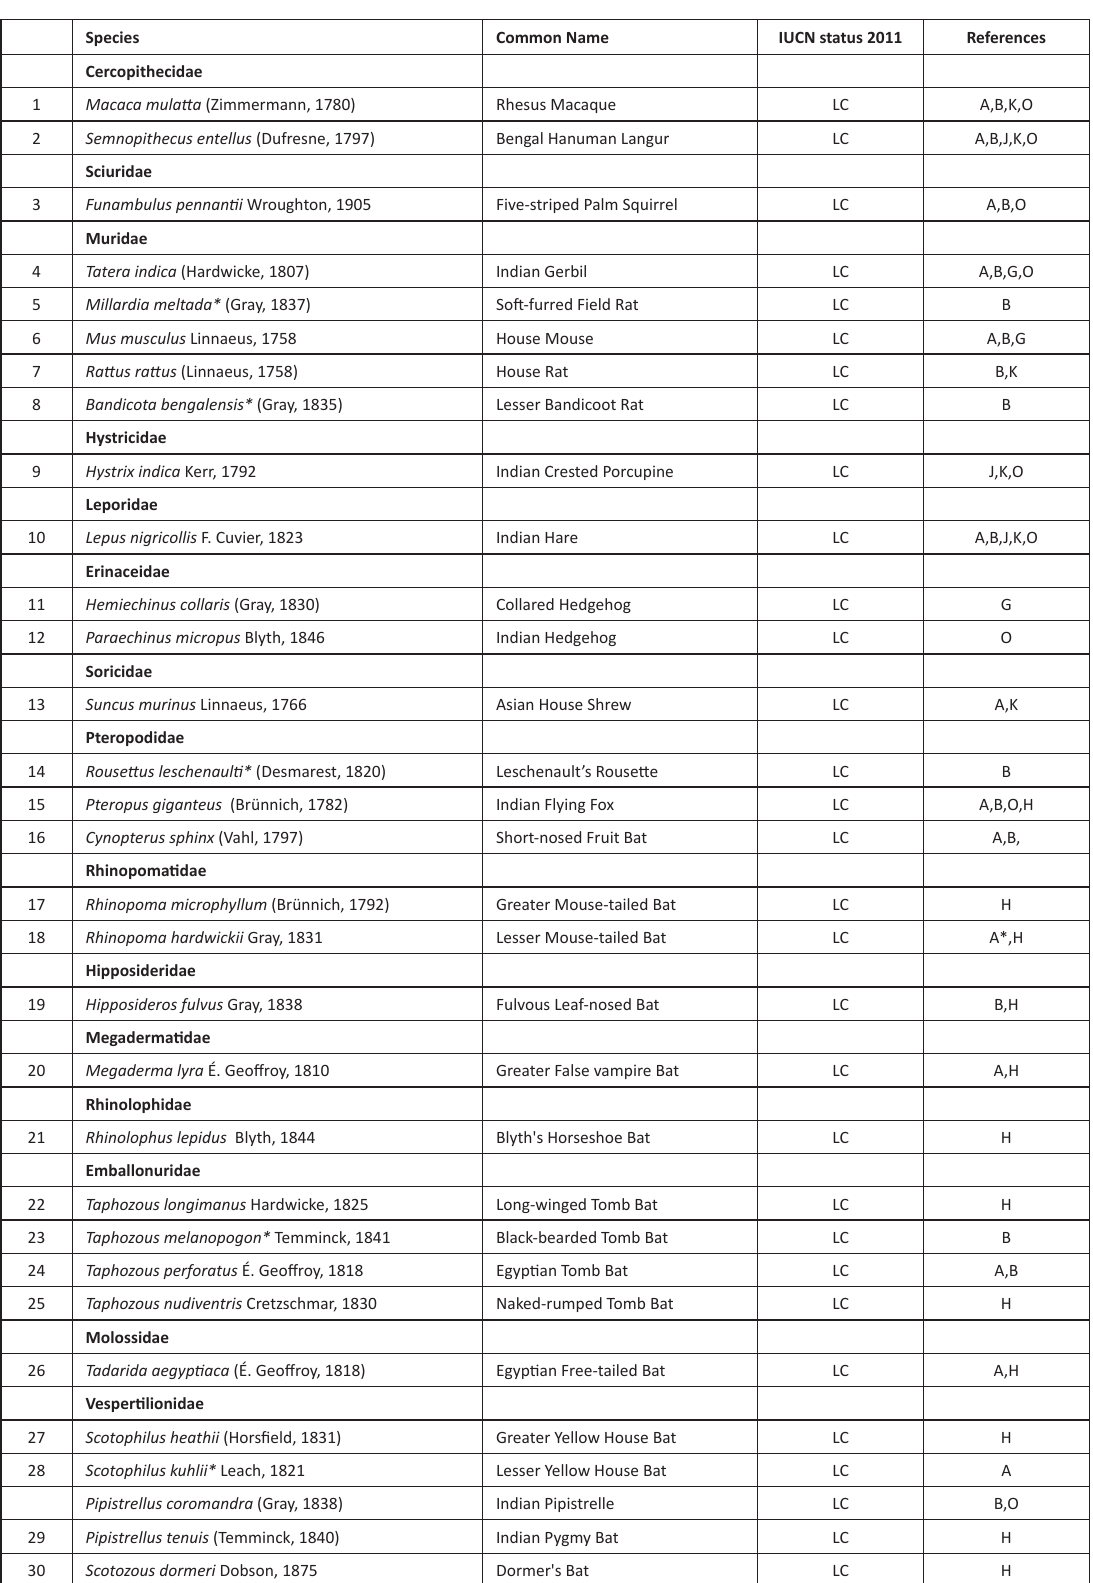
Table 5. Checklist of mammals of the Chambal River